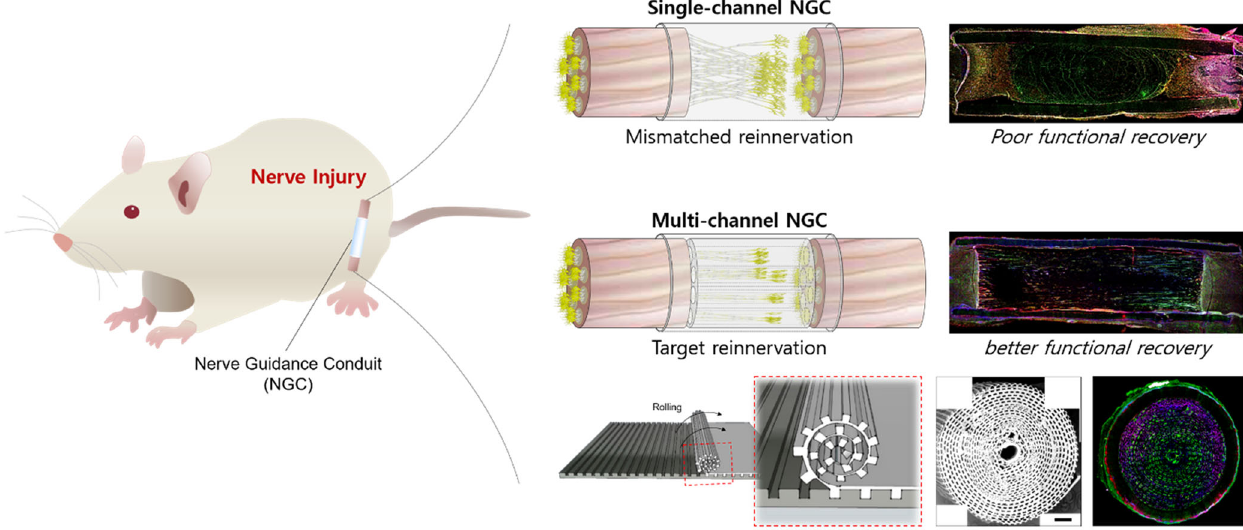
Fig. 6 Summary fi gure. This paper deals with a micropattern-based method for fabricating size-tunable nerve guidance conduits (NGCs) with hundreds of microchannels capable of recruiting stem cells, with this recruitment ability derived from the properties of a substrate composed of substance P (SP)-immobilized PLCL (PLCL-SP). For functional recovery in peripheral nerve injury (PNI) and spinal cord injury (SCI), correct target reinnervation of nerve fi bers is essential. However, hundreds of nerve fi bers in single-channel NGCs cannot be reinnervated in place because of the extension of lateral buds on every side. In contrast, multichannel NGC maximizes functional recovery by minimizing mismatched reinnervation through a guide to the target fi ber along the channel. In addition, it induces enhanced nerve regeneration by recruiting endogenous stem cells by substance showed higher SFI than the single-channel groups, and the well-known equation (Fig. 5c). Reversed autograft transplantation increase in SFI for the mspNGC group was particularly rapid at 4- is the gold standard and supports the best nerve recovery. A and 8-weeks post-surgery (Fig. 5d). This is because of the higher gradual improvement in functional recovery was achieved probability of target reinnervation owing to multiple channels, as following the introduction of NGCs. The two multichannel groups